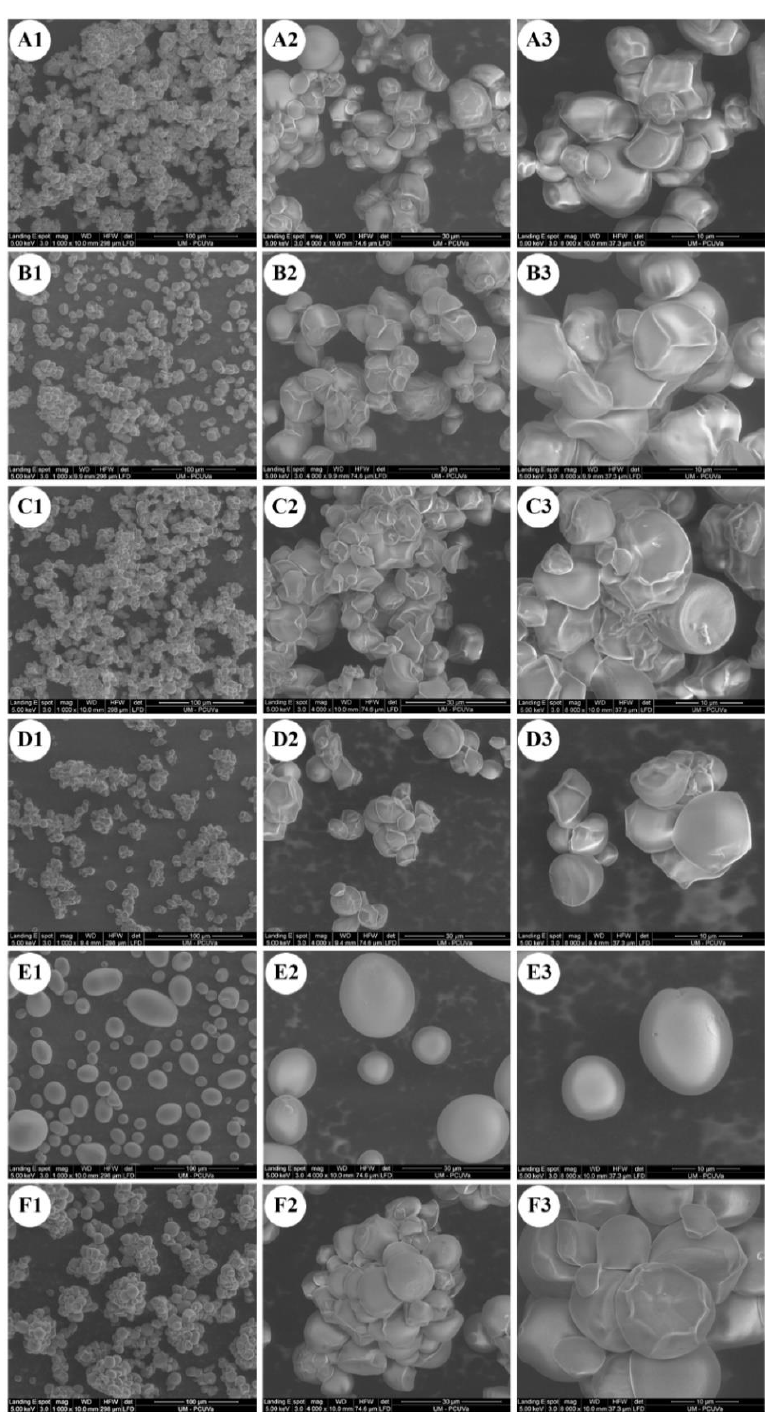
Figure 1. SEM images of starches from four cultivars of anchote ( A – D ), potato starch ( E ), and cassava starch ( F ); ( A ) D01S = Desta 01 starch; ( B ) D24S = Desta 24 starch; ( C ) WHTS = white starch; ( D ) REDS = red starch; ( E ) PS = potato starch; ( F ) CS = cassava starch, at magnifications of (1) 1000×, (2) 4000×, and (3) 8000×.